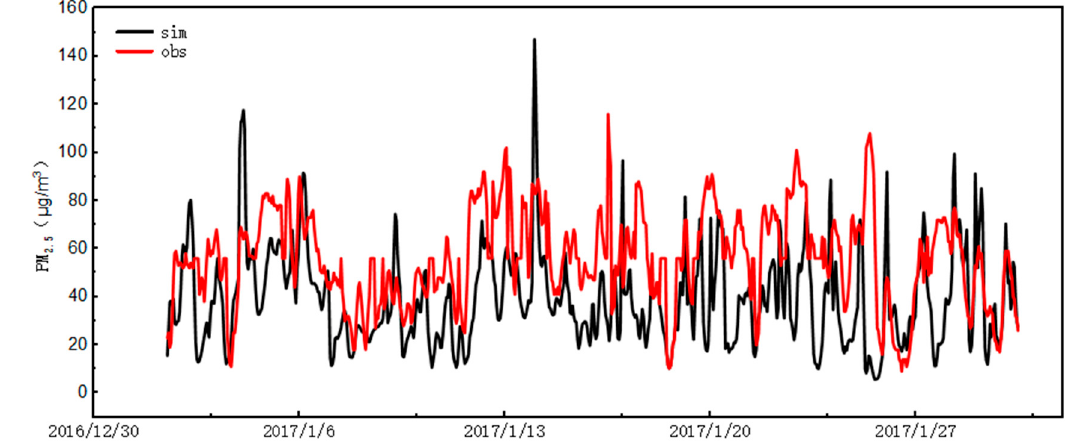
Figure 8. Time series of Bozhou PM 2.5 in January 2017. Table 2. Statistical indicators of Bozhou CMAQ model evaluation in January 2017.